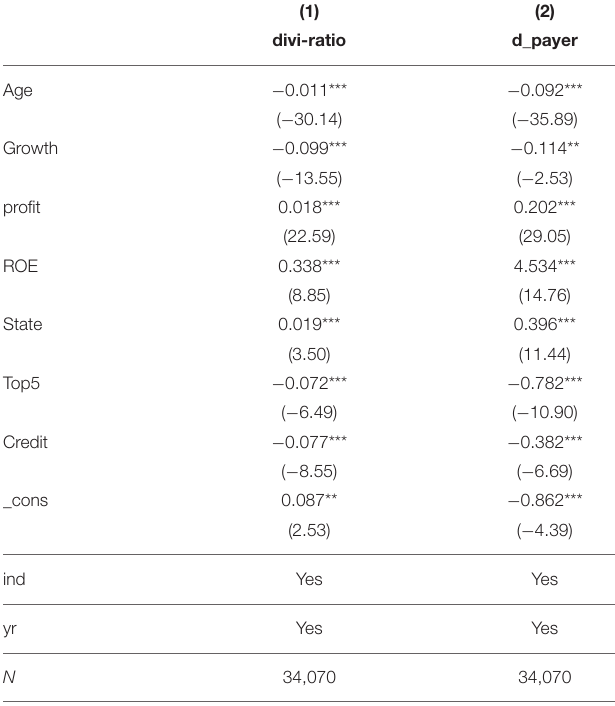
TABLE 5 | Propensity score matching (PSM